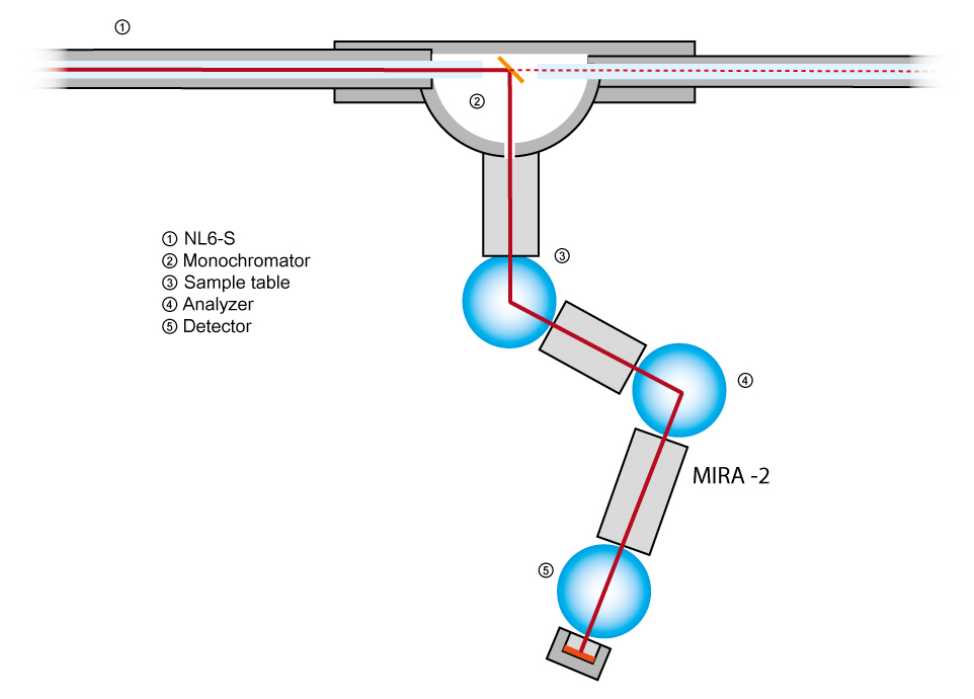
Figure 3: Schematic drawing of